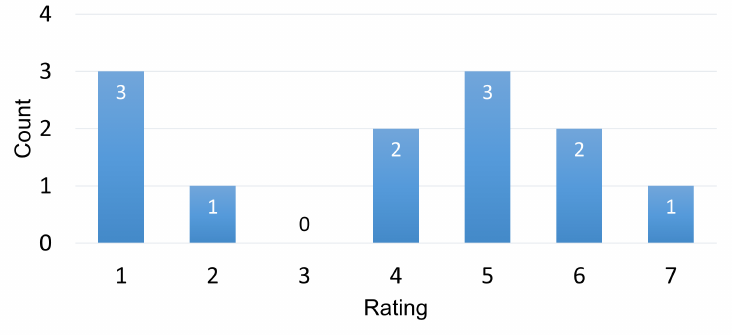
Figure 12. Answers to the statement “I found the automatic pausing to be more distracting than helpful”. 1 = fully disagree, 7 = fully agree; n = 12.